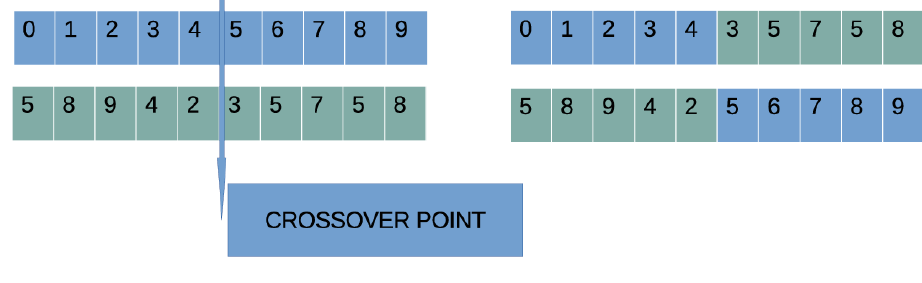
Figure 2. Example of one-point